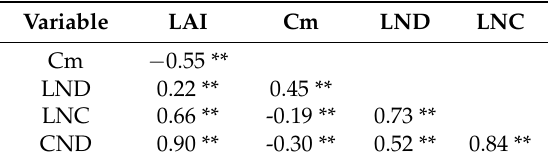
Table 5. Correlations between agronomic variables ( n = 384). Variable